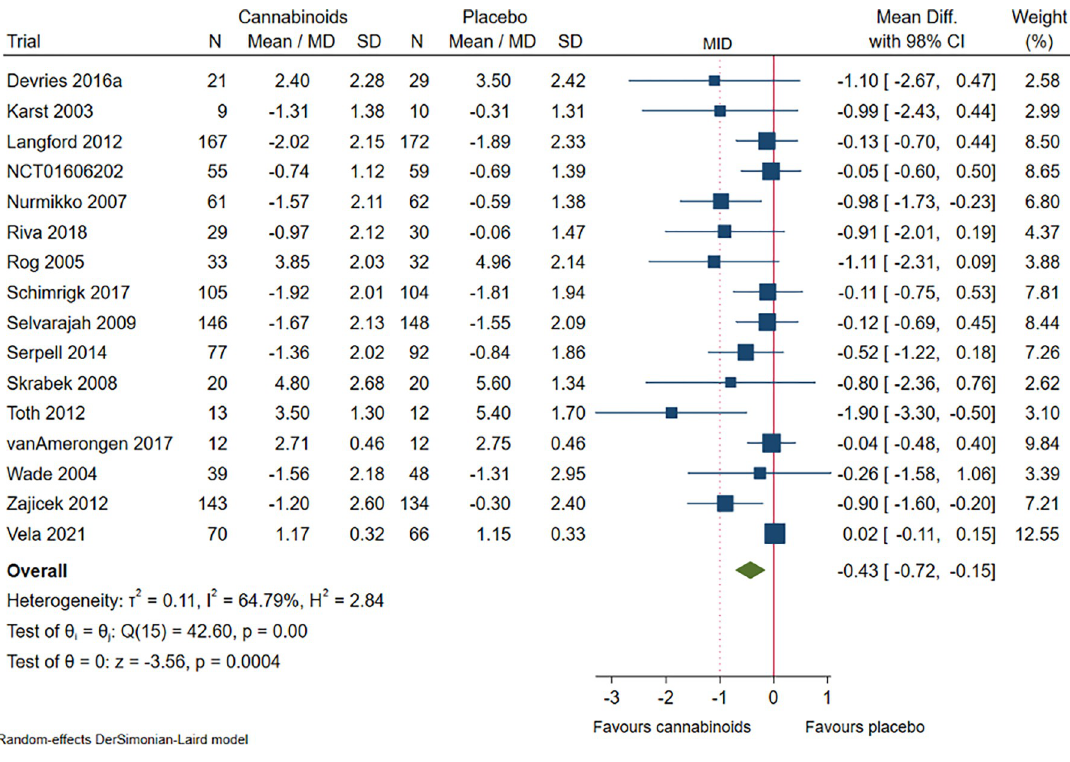
Fig 2. Forest plot of the meta-analysis of chronic pain with 98%